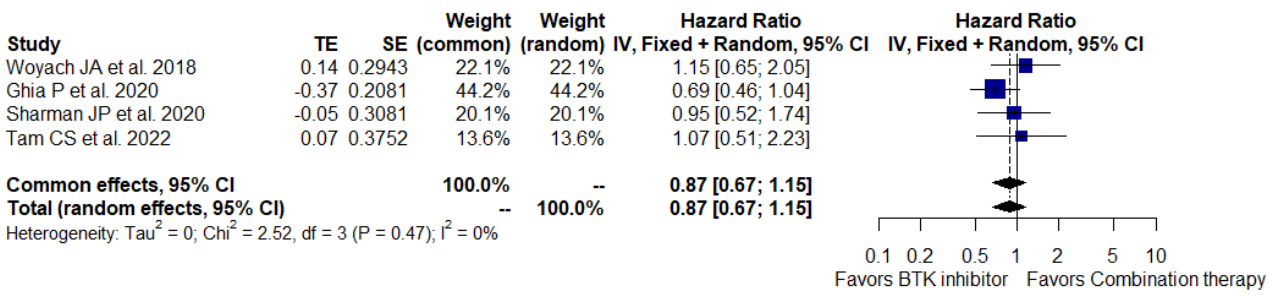
Figure 2. Forest plot for progression – free survival ( A ) and sensitivity analysis of progression – free survival ( B ) [25,30,42,45].